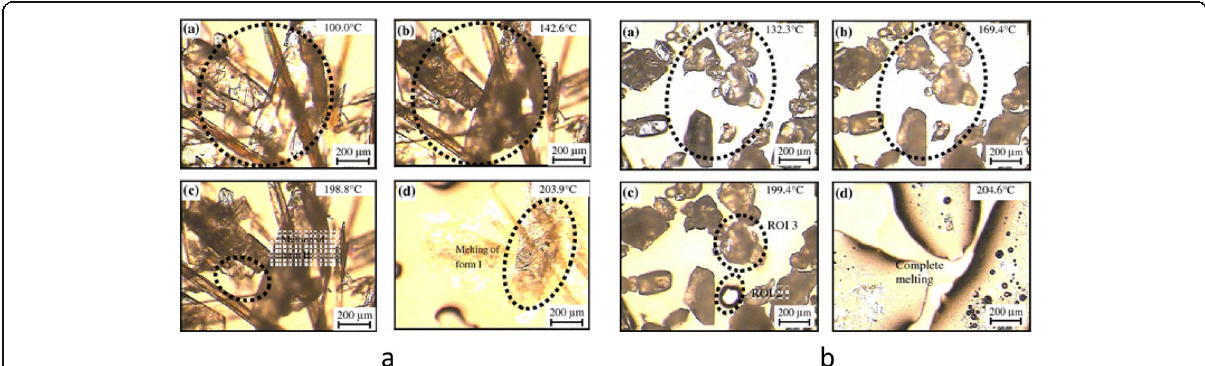
Fig. 3 HSM micrographs of sulfathiazole crystals prepared by method I and III 3a: a- 100°C, b- 142.6°C, c- 198.8°C, d- 203.9°C; 3b: a- 132.°C, b- 169.4°C, c-